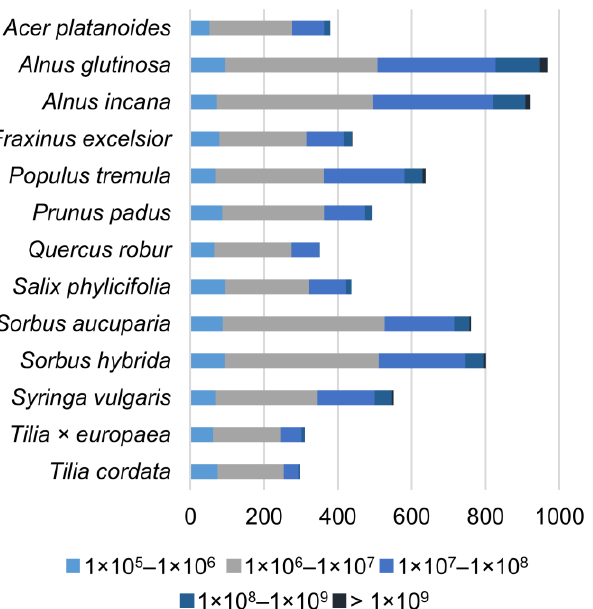
Figure 2. The number of features detected with MZmine 2 in the UHPLC-Orbitrap-MS data of the studied species. On the basis of the peak areas, the features were categorised into six categories that are denoted with different